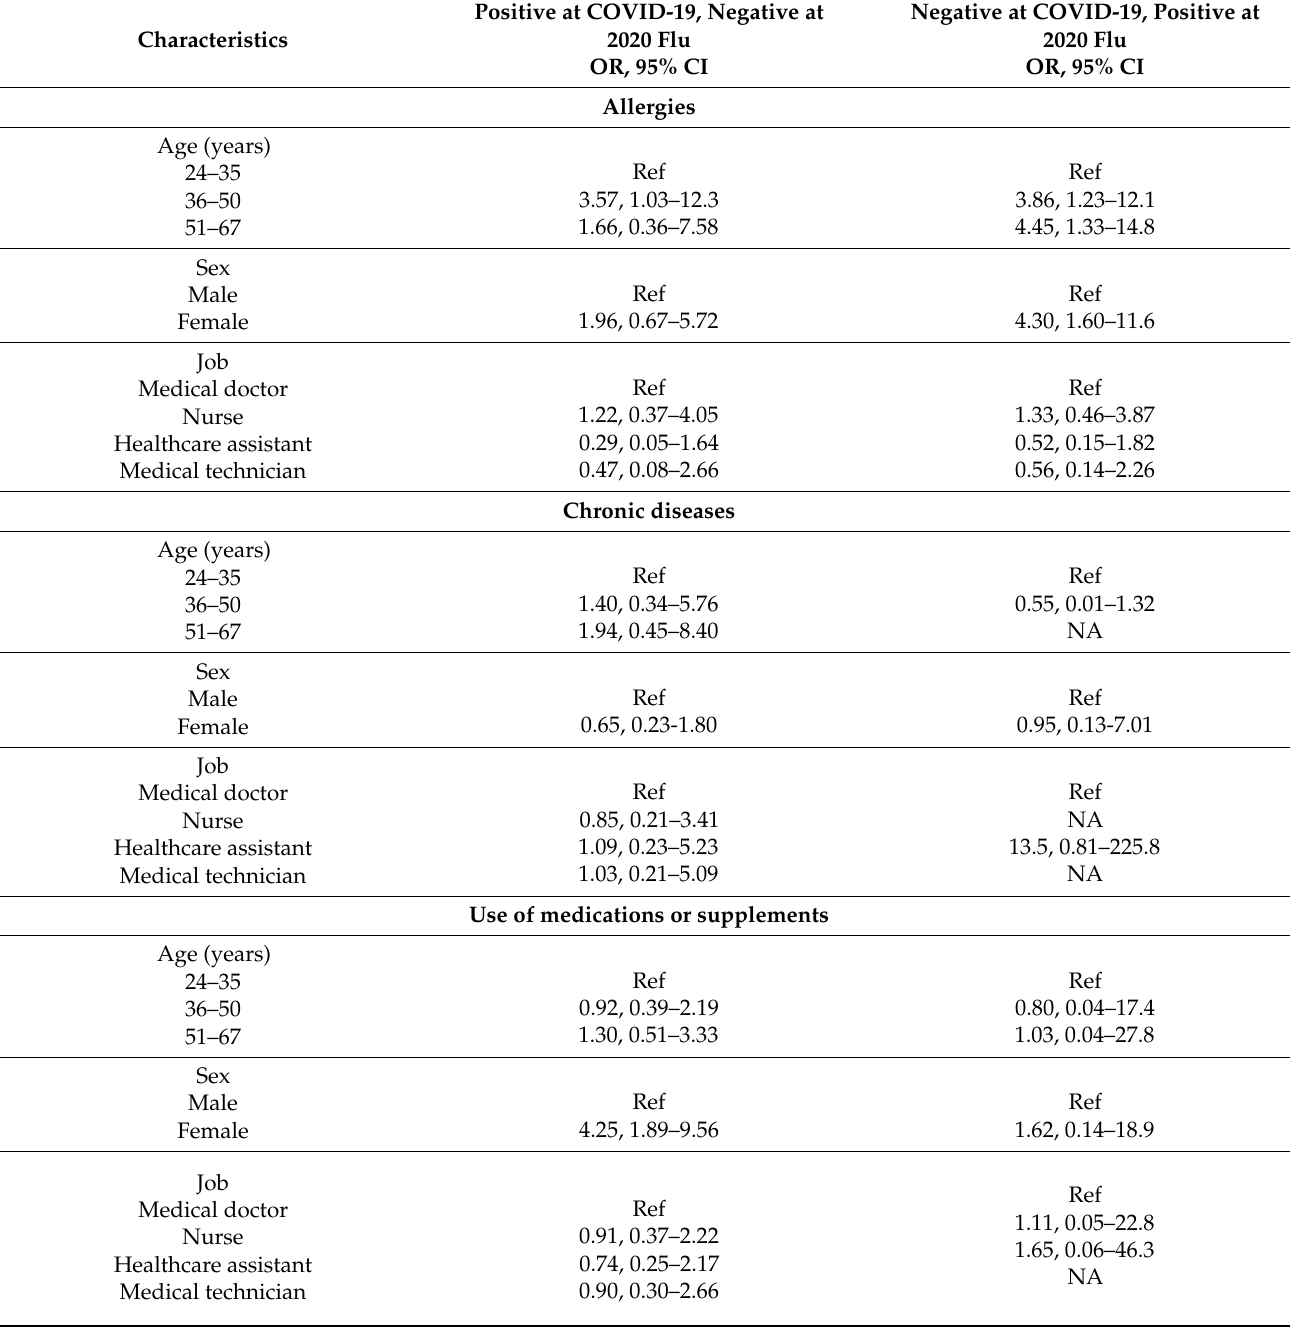
Table 4. Odds ratios for discordance in reporting the outcomes (positive or negative answer to questions about allergies, chronic diseases, and medications/supplements use) between COVID-19 and 2020 flu questionnaires (reference category: concordant